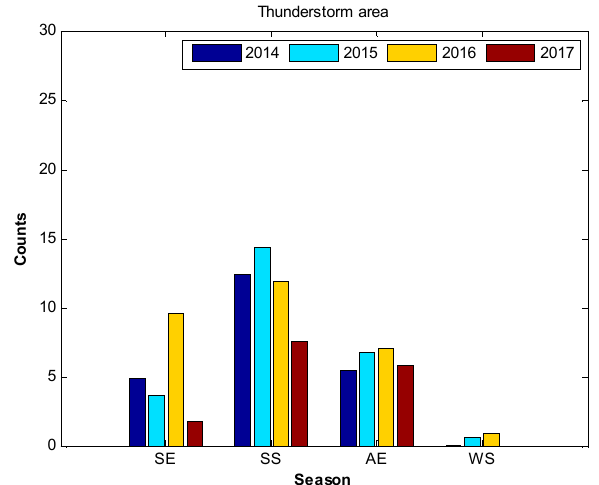
Figure 9. The average thunderstorm area for different seasons during each year from 2014 to 2017. SE, SS, AE, and WS represent the spring equinox, summer solstice, autumn equinox, and winter solstice,